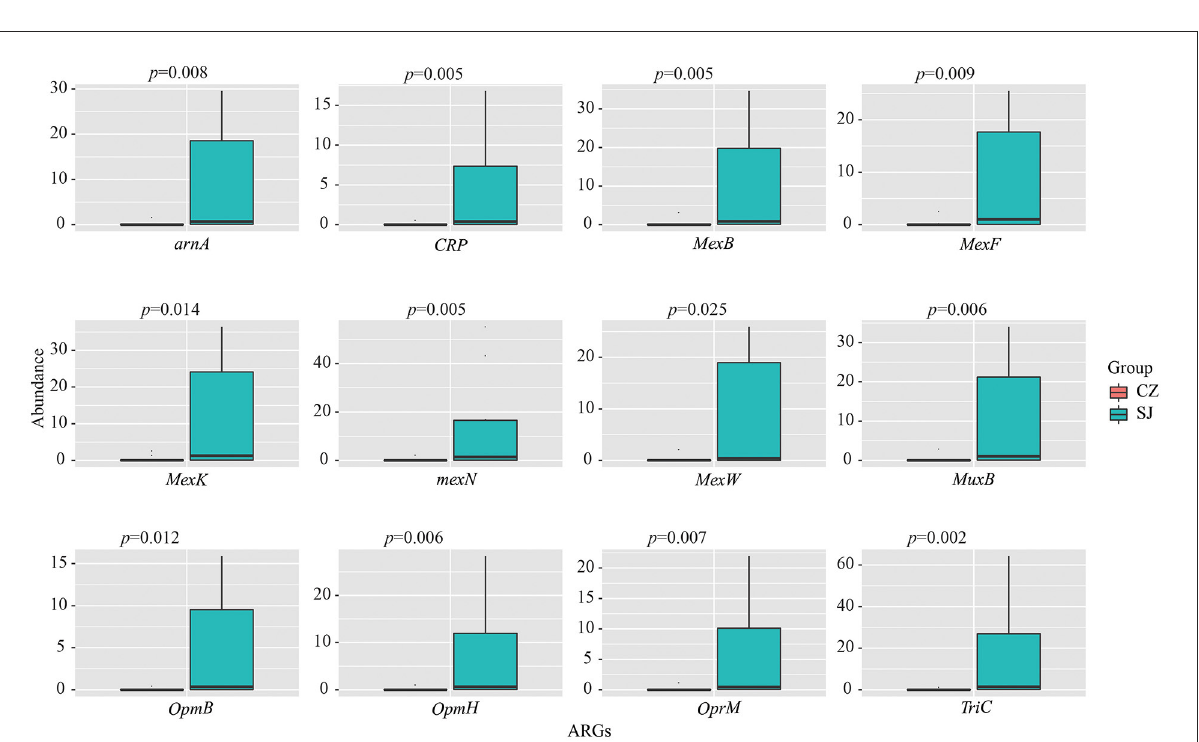
FIGURE6 The top 12 antibiotic-resistant genes (ARGs) in Anser erythropus sampled from Shengjin (SJ) and Caizi (CZ) Lakes.